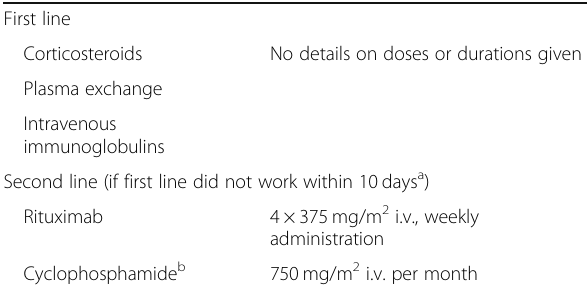
Table 4 First-line and second-line therapy in autoimmune encephalitides according to